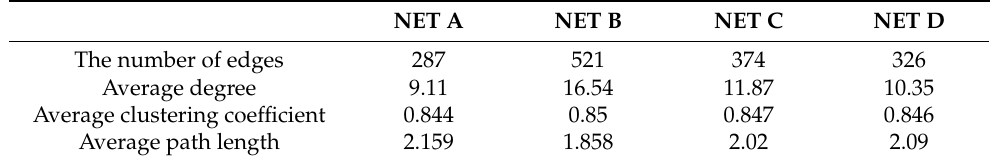
Table 1. Network topology